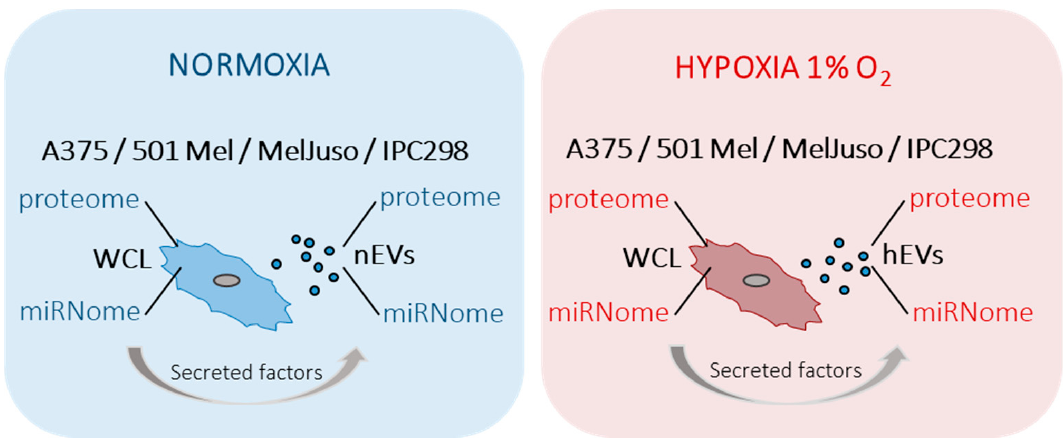
Figure 1. Schematic overview of the study design. Four di ff erent melanoma cell lines (A375, 501Mel, MelJuso and IPC298) were cultured under normoxic (blue) or hypoxic (red) conditions. Proteomes and miRNomes of the cells and of the respective small extracellular vesicles (EVs) were characterised by mass spectrometry and qPCR arrays and miRNA microarrays, respectively. WCL: whole cell lysate, nEVs: normoxic small extracellular vesicles, hEVs: hypoxic small extracellular